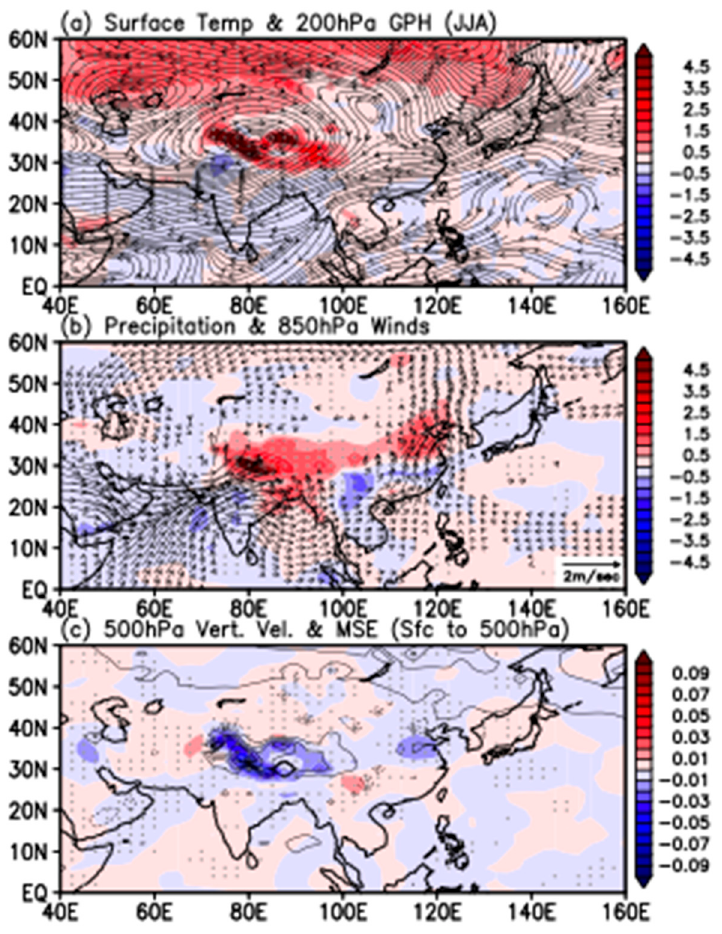
Figure 6. Horizontal distributing showing anomalies in ( a ) surface temperature ( ◦ C), and geopotential height at 200 hPa, ( b ) precipitation (mm day − 1 ) and 850 hPa winds (m s − 1 ), and ( c ) vertical motion at 500 hPa (color shading, in units of Pa s − 1 ) and lower troposphere moist static energy (contours, in units of watt m − 2 ). GPH: Geopotential